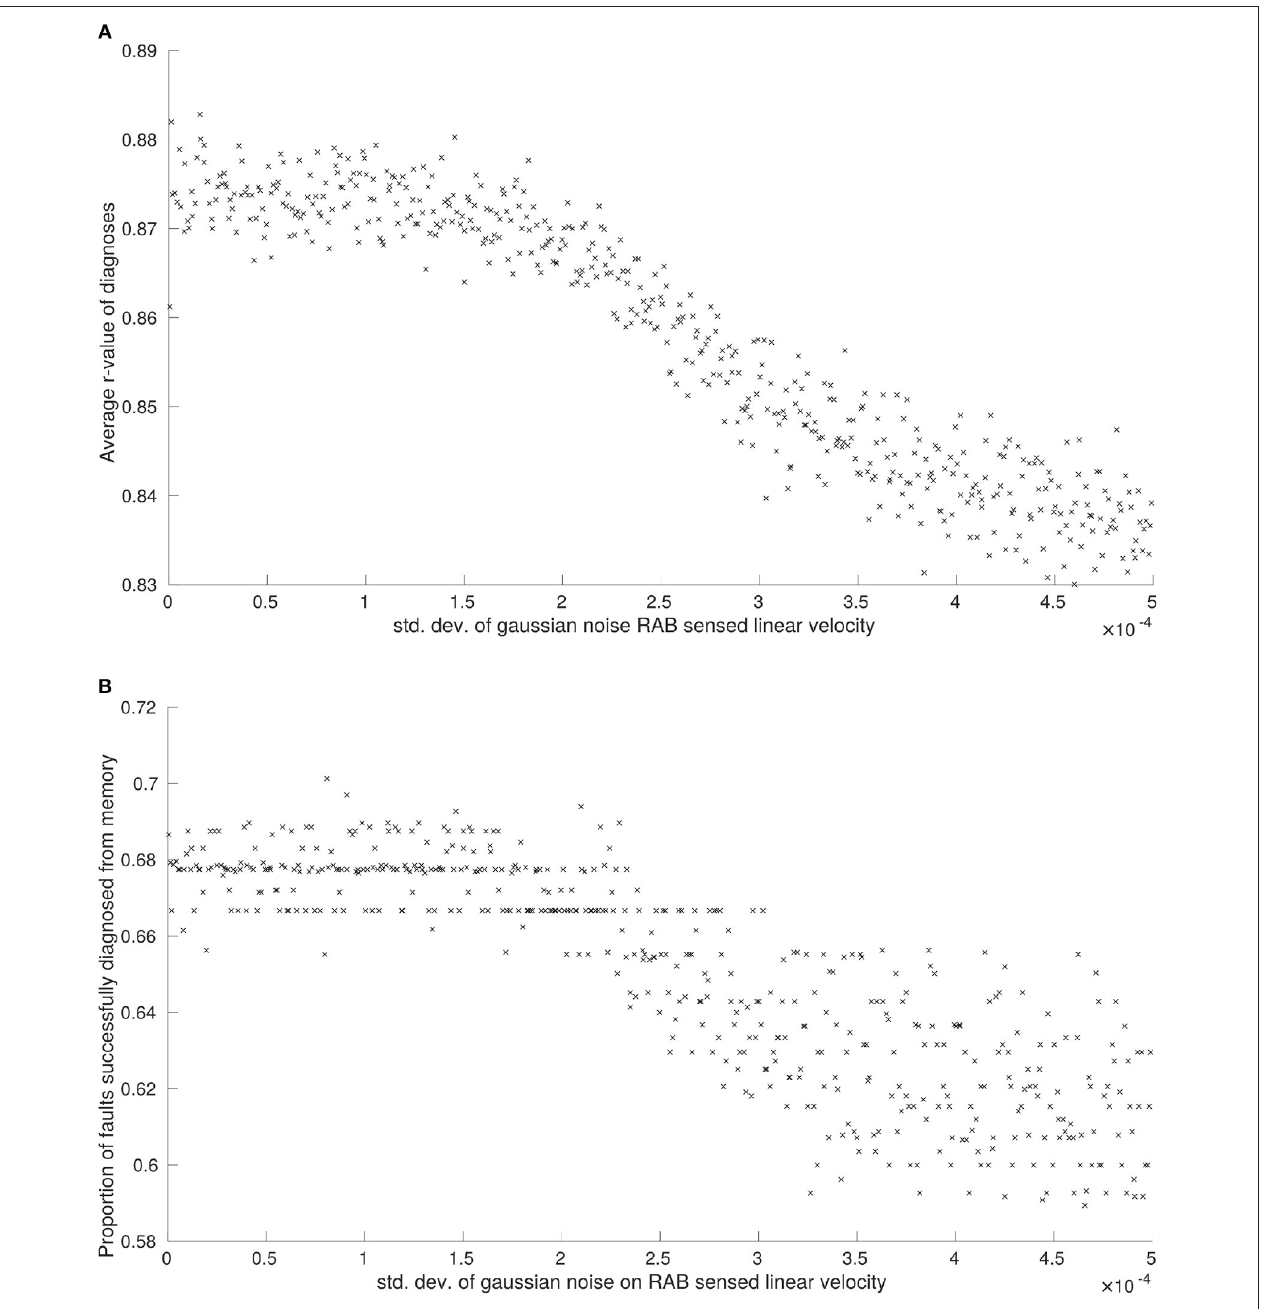
FIGURE 2 | (A) The effects of noise on RAB sensed linear velocity on median r-values between diagnoses, and (B) the effects of noise on RAB sensed linear velocity measurements on the proportion of faults successfully diagnosed from